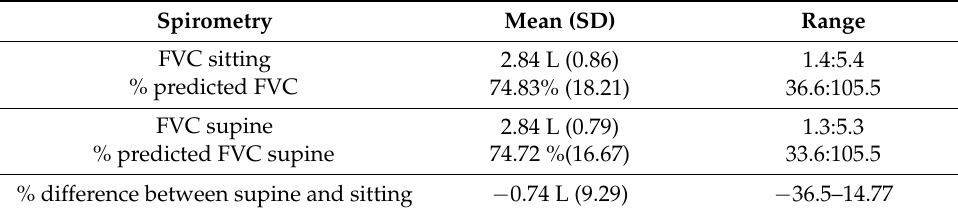
Table 1. FVC in FRDA